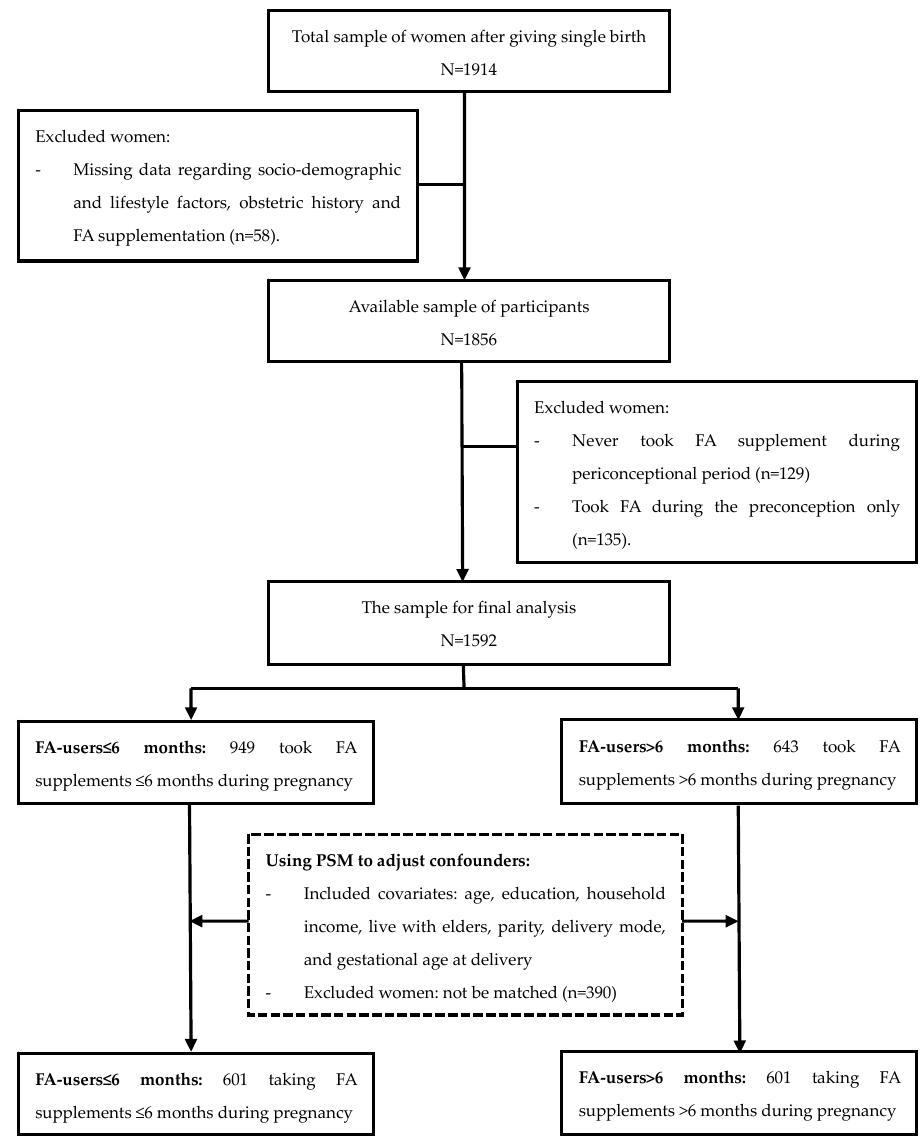
Figure 1. Flow diagram of enrolment in the study. FA: folic acid; PSM: propensity score matching.